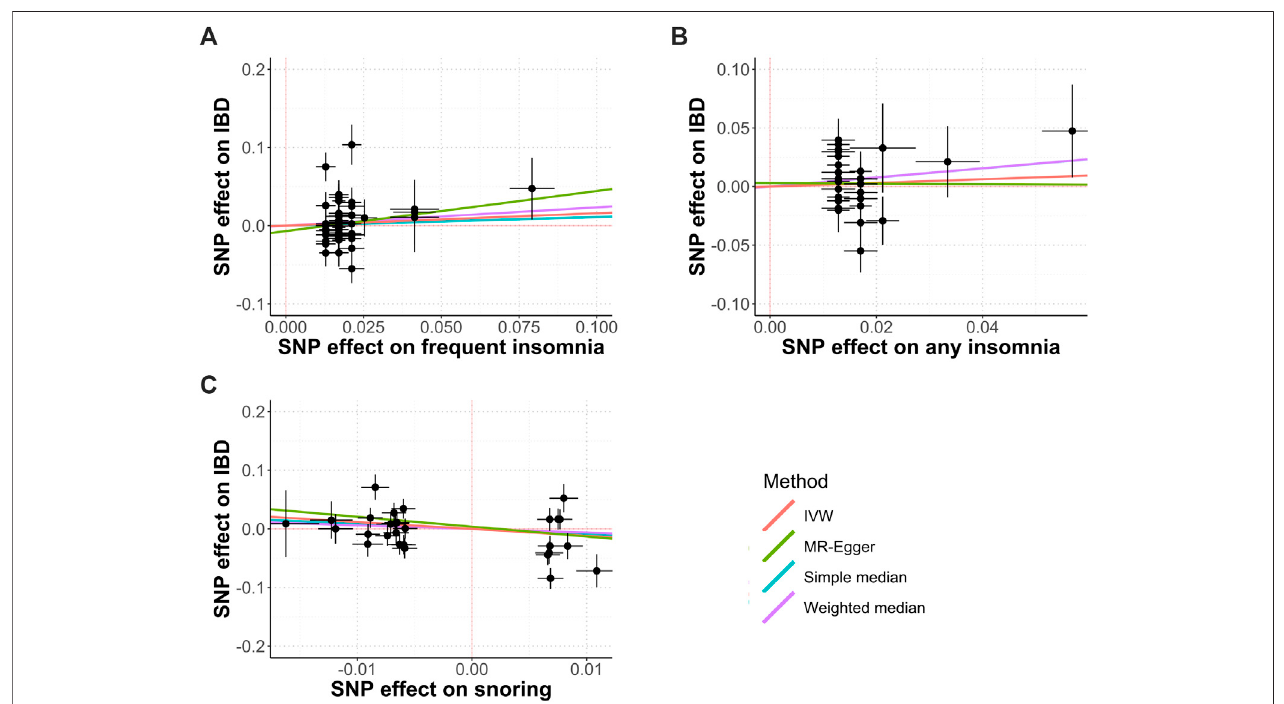
FIGURE 3 | Causal relationships between insomnia, snoring, and IBD. Abbreviations: IVW, inverse-variance weighted. MR, mendelian randomization. SNP, single nucleotidepolymorphisms.Annotation:ScatterplotsoftheIBD-SNPassociations(y-axis)versusthesleep-traits-SNPassociations(x-axis)wereshowed,withhorizontal and vertical lines showing 95% con fi dence intervals for each association. (A) Frequent insomnia; (B) Any insomnia; (C) Snoring.